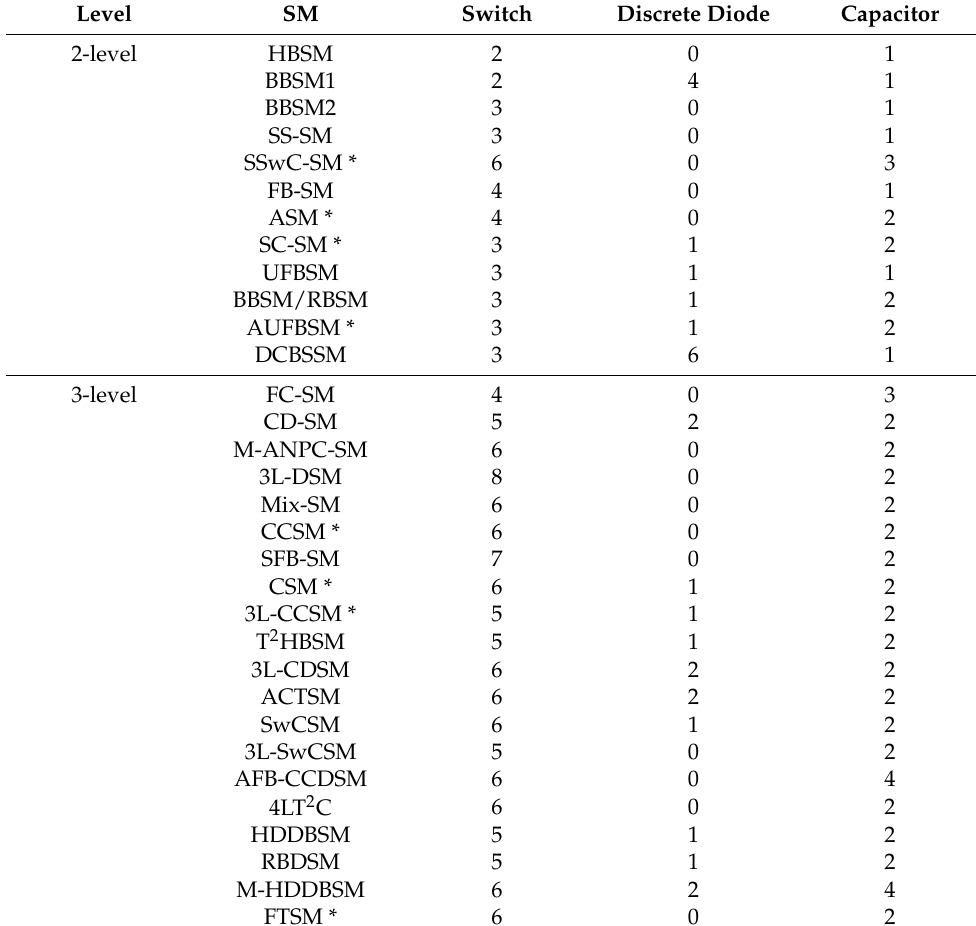
Table 7. Number of components in